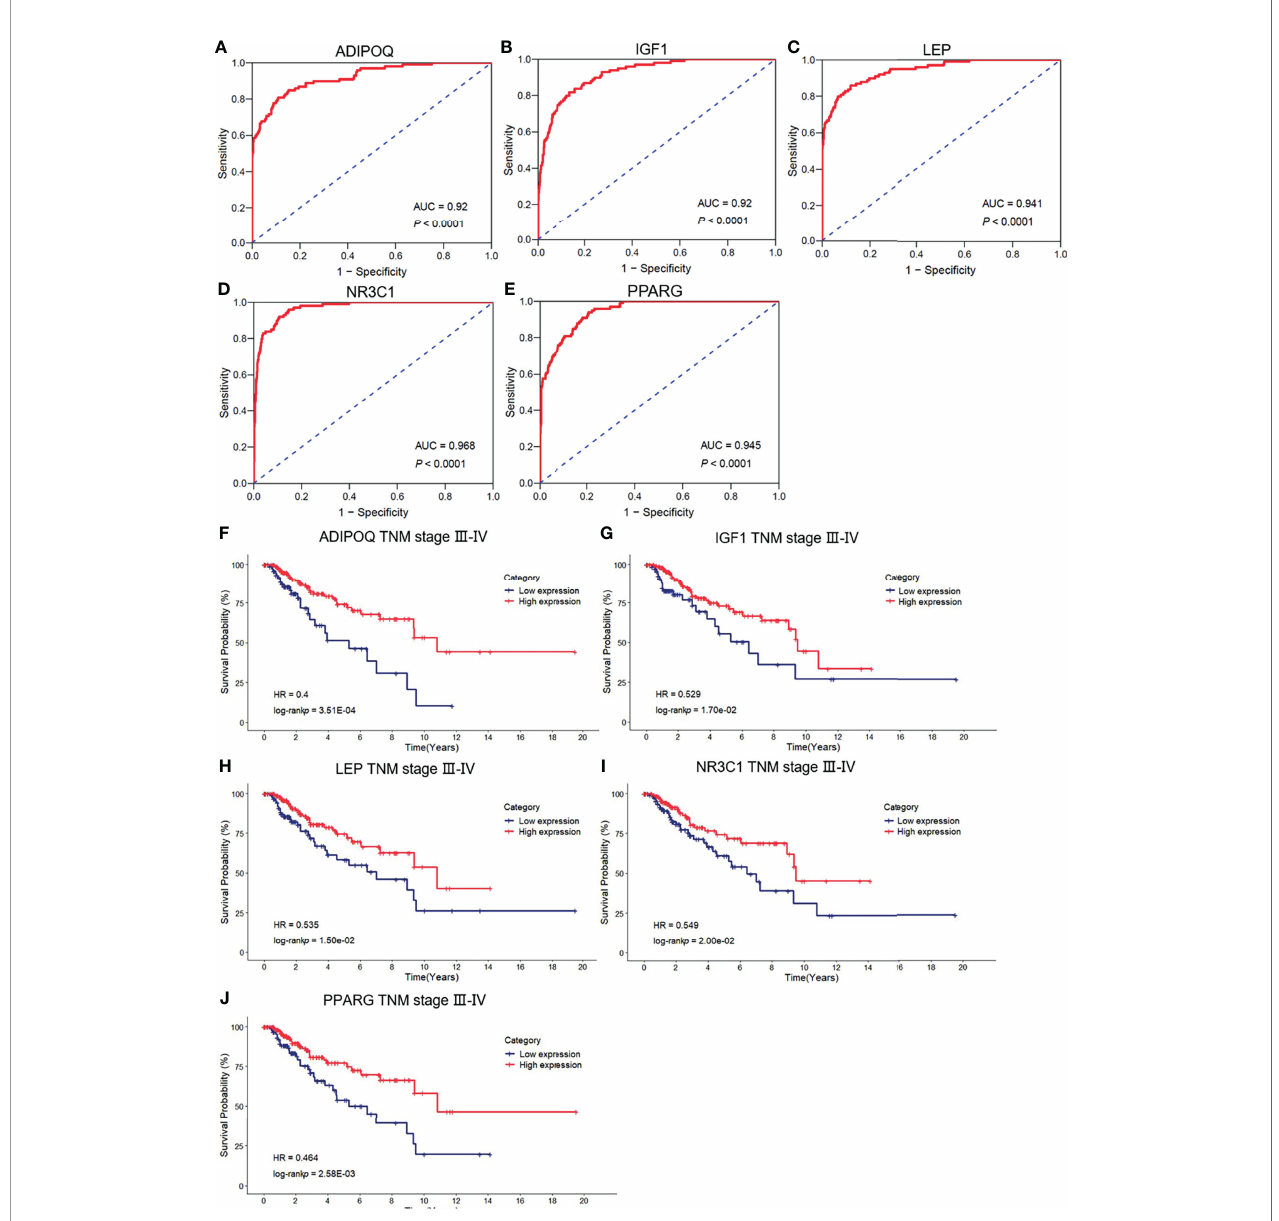
FIGURE 6 | The ROC curve of the risk score in nontumor tissues and breast cancer tissues. (A – E) The ROC curve of the validation of the diagnostic value of fi ve immune-related hug genes. (F – J) Kaplan – Meier survival analysis for the subgroup of overall survival (OS) based on tumor – node – metastasis (TNM)